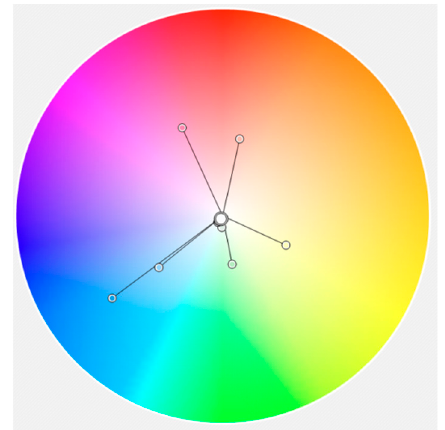
Figure 12. The HERE Maps color analysis.